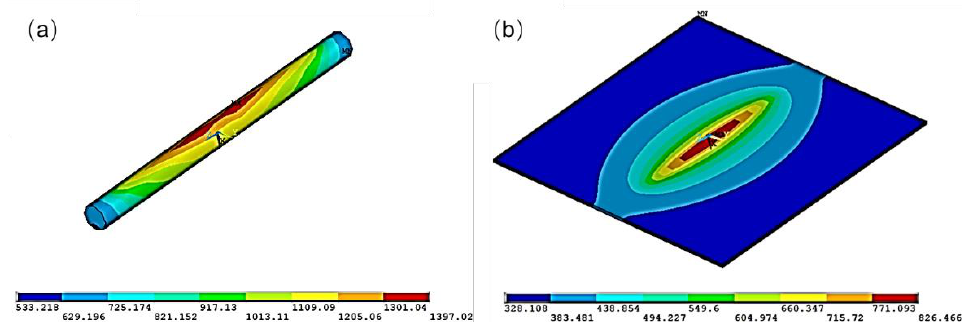
Figure 9. Temperature distribution of ( a ) an AuNi 9 microwire and ( b ) Au layer under the optimized parameters (0.275 kA, 3 ms, and 28.7 N).